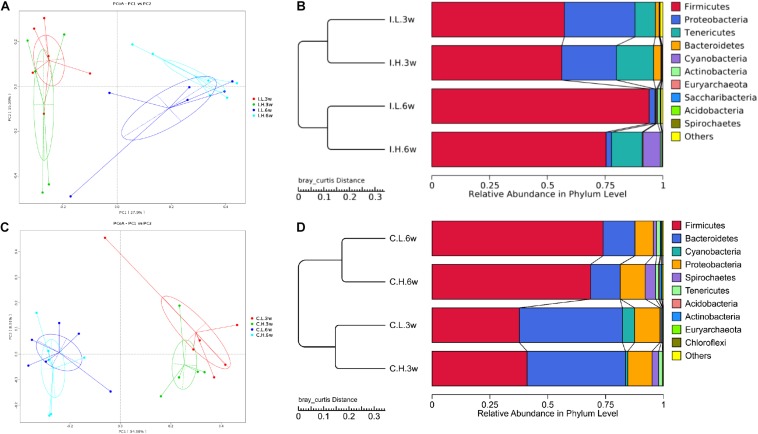
Principal coordinate analysis and unweighted pair-group method with arithmetic mean (UPMGA) cluster analysis of microbial communities in the ileum and cecum of weaned piglets after 3 and 6 weeks of feeding. (A) Principal coordinate analysis (PCoA) of microbial communities in the ileum, (B) UPMGA cluster analysis of microbial communities in the ileum, (C) PCoA of microbial communities in the cecum, and (D) UPMGA cluster analysis of microbial communities in the cecum. I, ileal microbiota; C, cecal microbiota; L, control group; H, Cu-supplemented group; 3w, 3 weeks of feeding after weaning; 6w, 6 weeks of feeding after weaning.